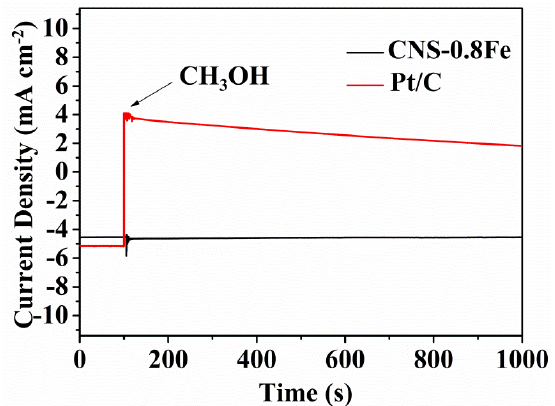
Figure 9. Methanol crossover tests of CNS-0.8Fe and Pt/C at 1600 rpm.